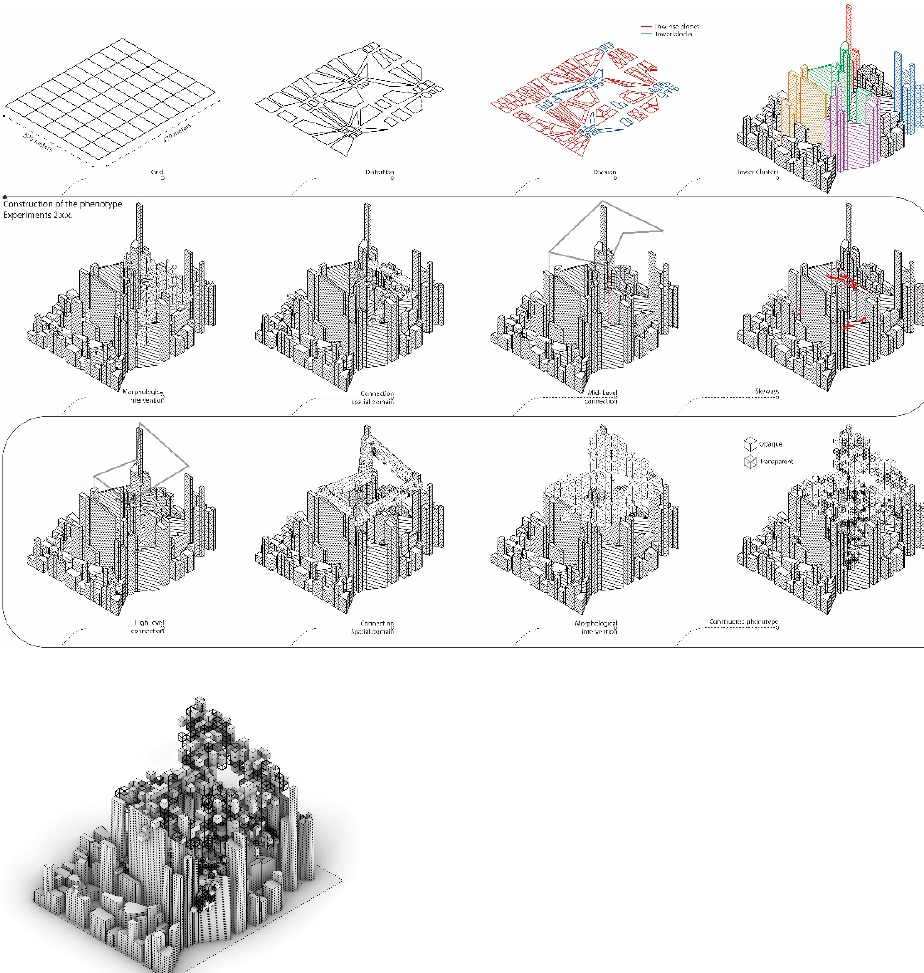
Figure 8. Step-by-step process for the phenotype’s construction; each step presents the chromosome applied and the morphological impact of its